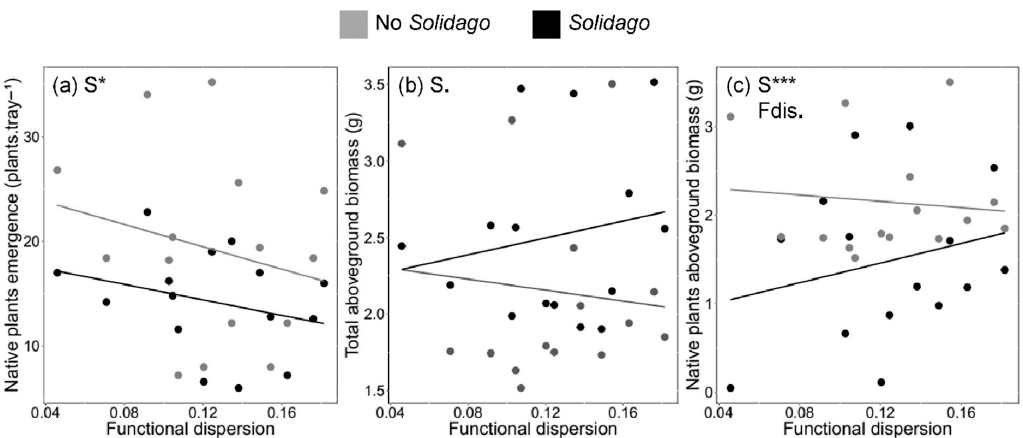
Figure 2. Effects of functional diversity, represented by the functional dispersion (Fdis) index and Solidago gigantea (S) on plants emergence and aboveground biomass; ( a ) shows native plant emergence according to functional dispersion and the presence of the invasive alien plant, while ( b ) shows native plant biomass in relation to functional dispersion and the presence of the invader; ( c ) shows plant communities total aboveground biomass varying according to the functional dispersion and S. gigantea . Aboveground biomass was collected at the end of the experiment (16 weeks), while emergence was evaluated during the second week of the experimental period for each one of the communities, invaded or not. For the dependent variables, chi-squared values are presented in the text (*** p ≤ 0.001; * p ≤ 0.05; . p ≤ 0.10). p ≤